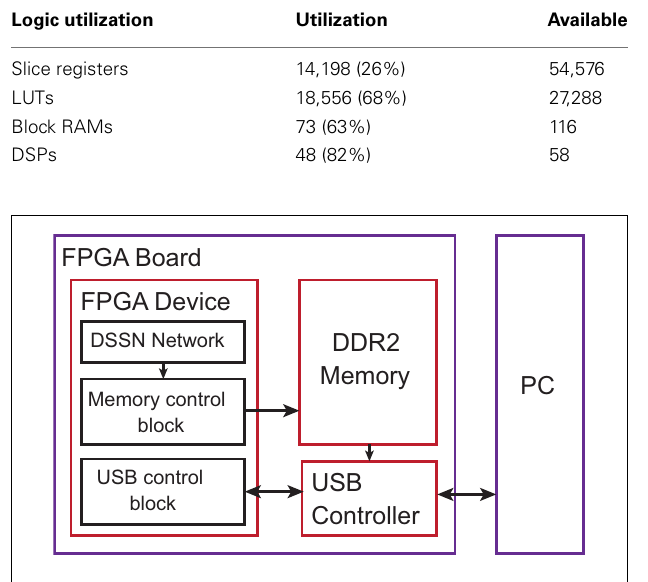
Table 3 | Device utilization on FPGA device.